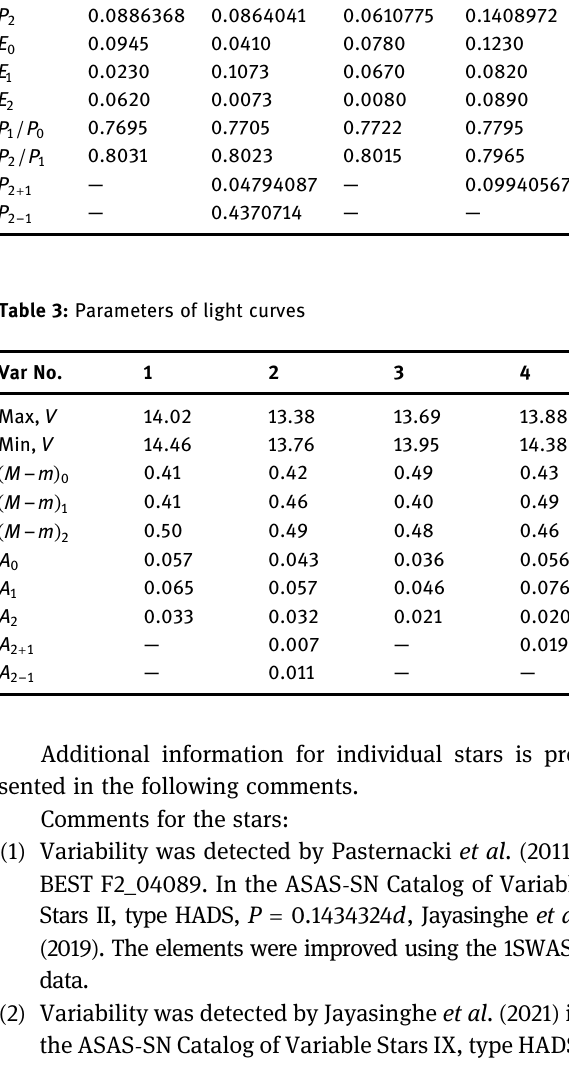
A 2 1 and A 2 1 ) . + −